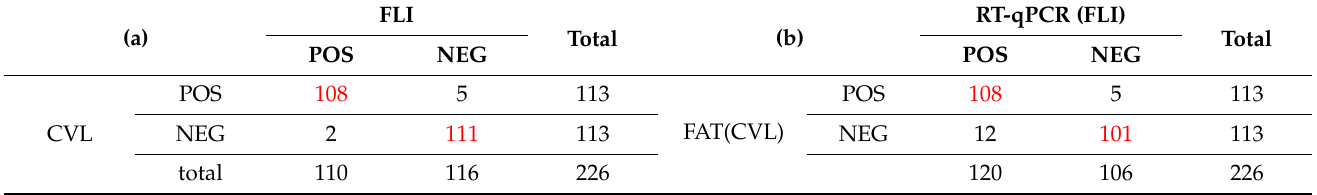
Table 2. Summary of interlaboratory comparison of FAT results obtained with 226 brain samples between CVL, Namibia and FLI, Germany (a) and comparison between RT-qPCR and FAT (CLV) (b).